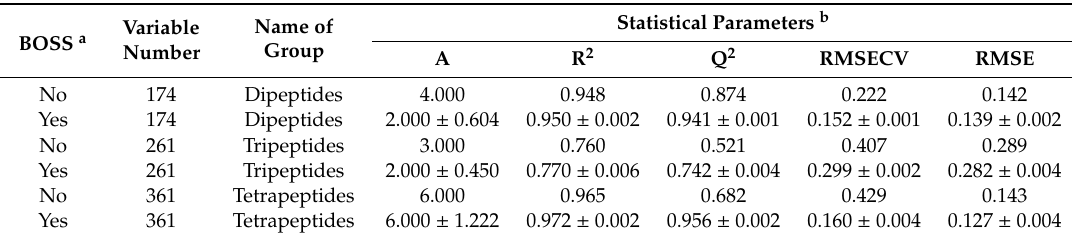
Table 1. Statistical parameters of quantitative structure–activity relationship (QSAR) models for di-, tri- and tetrapeptides using integrated descriptor sets.